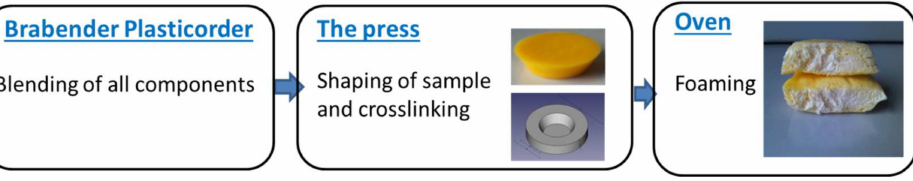
Figure 2. FPCM preparation.